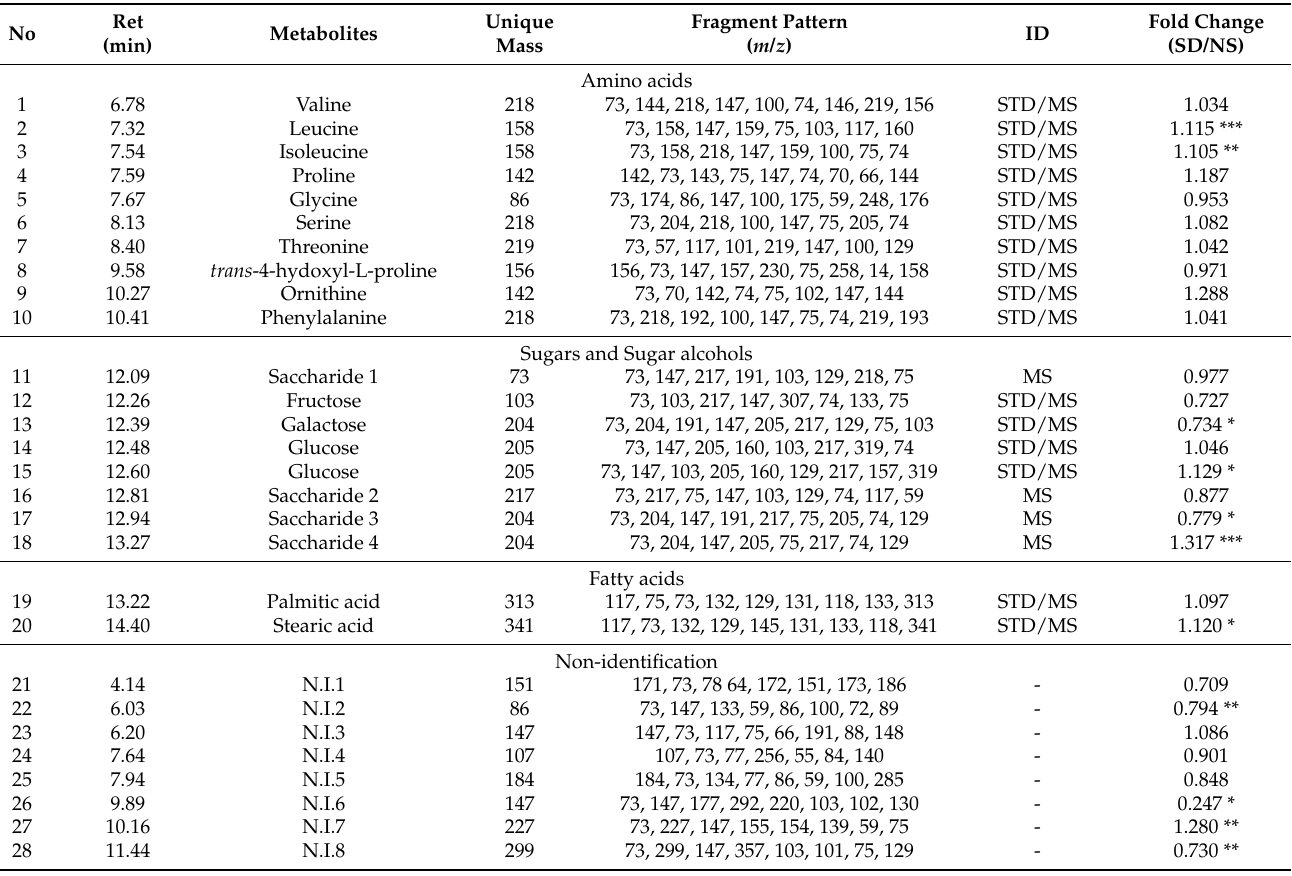
Table 3. List of twenty-eight metabolites altered by SD.